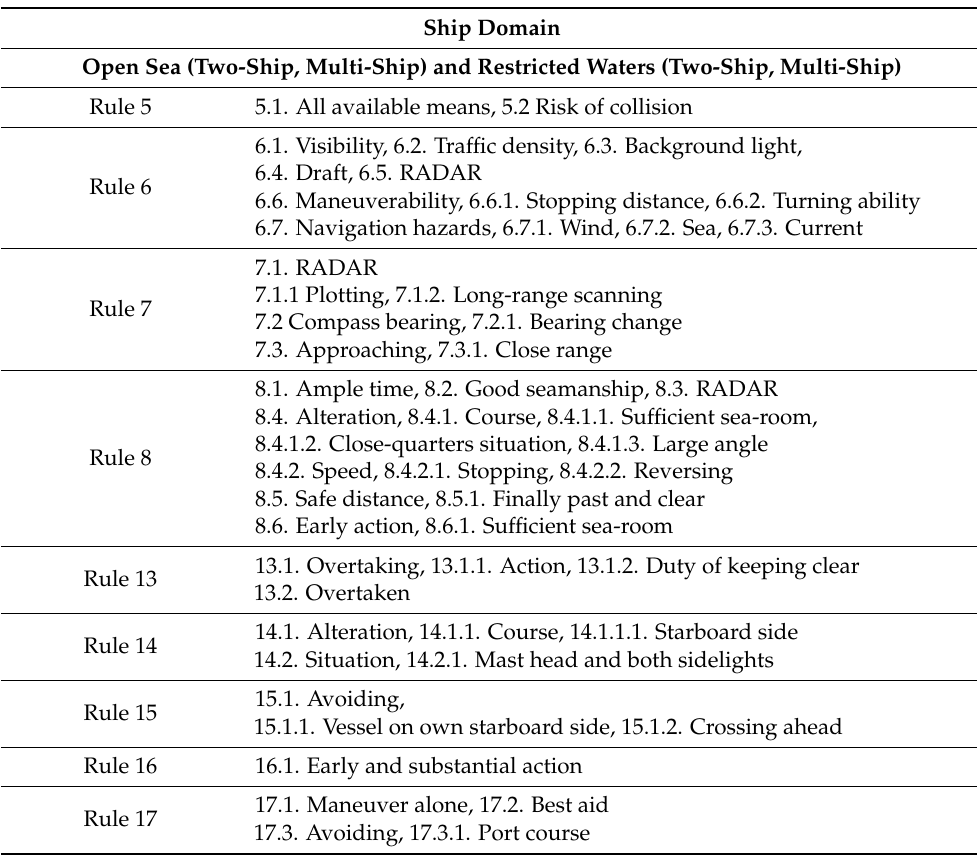
Table 6. Requirements analysis of ship domain.